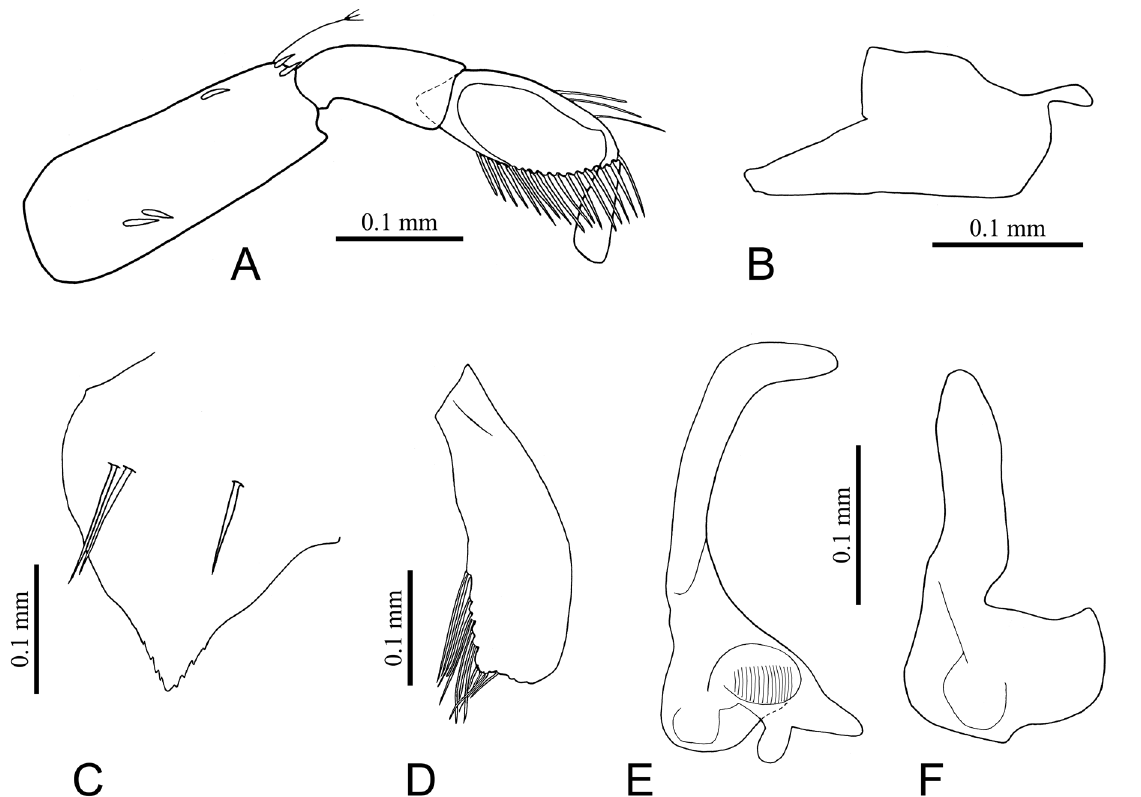
Fig. 10. Morphological features of Micronecta fulvopicta sp. nov., ♂, paratype (ZVNU). A . Fore leg. B . Prestrigilar flap. C . Median lobe of sternite VII. D . Free lobe. E . Right paramere. F . Left